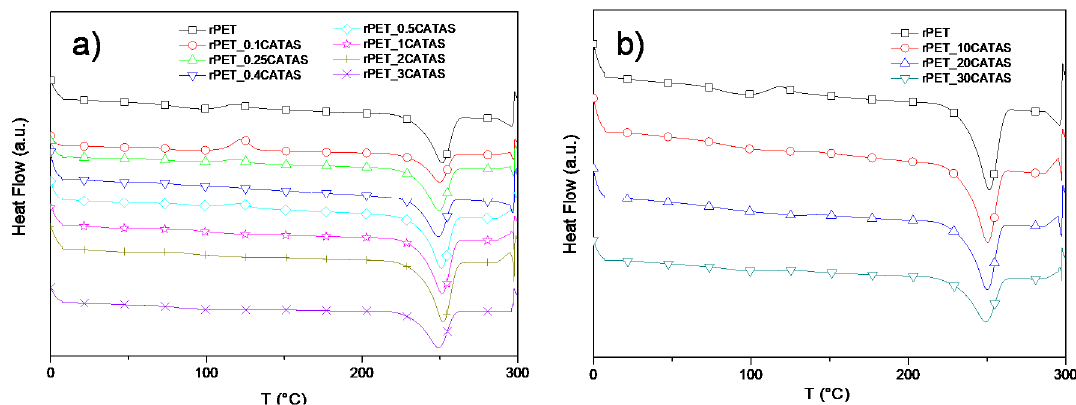
Figure 8. DSC heating scan for rPET and rPET/CATAS nanocomposites at low ( a ) and high ( b ) loading levels.